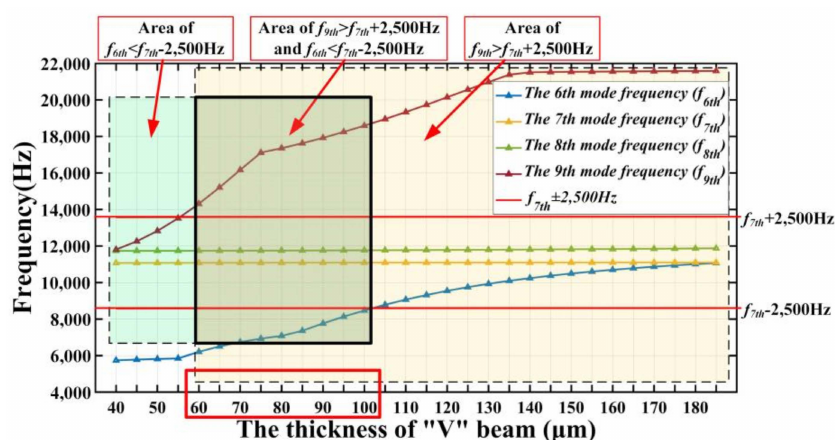
Figure 11. f 6th , f 7 th , f 8 th , and f 9 th of tuning forks resonant gyroscope models with di ff erent V-shaped beam